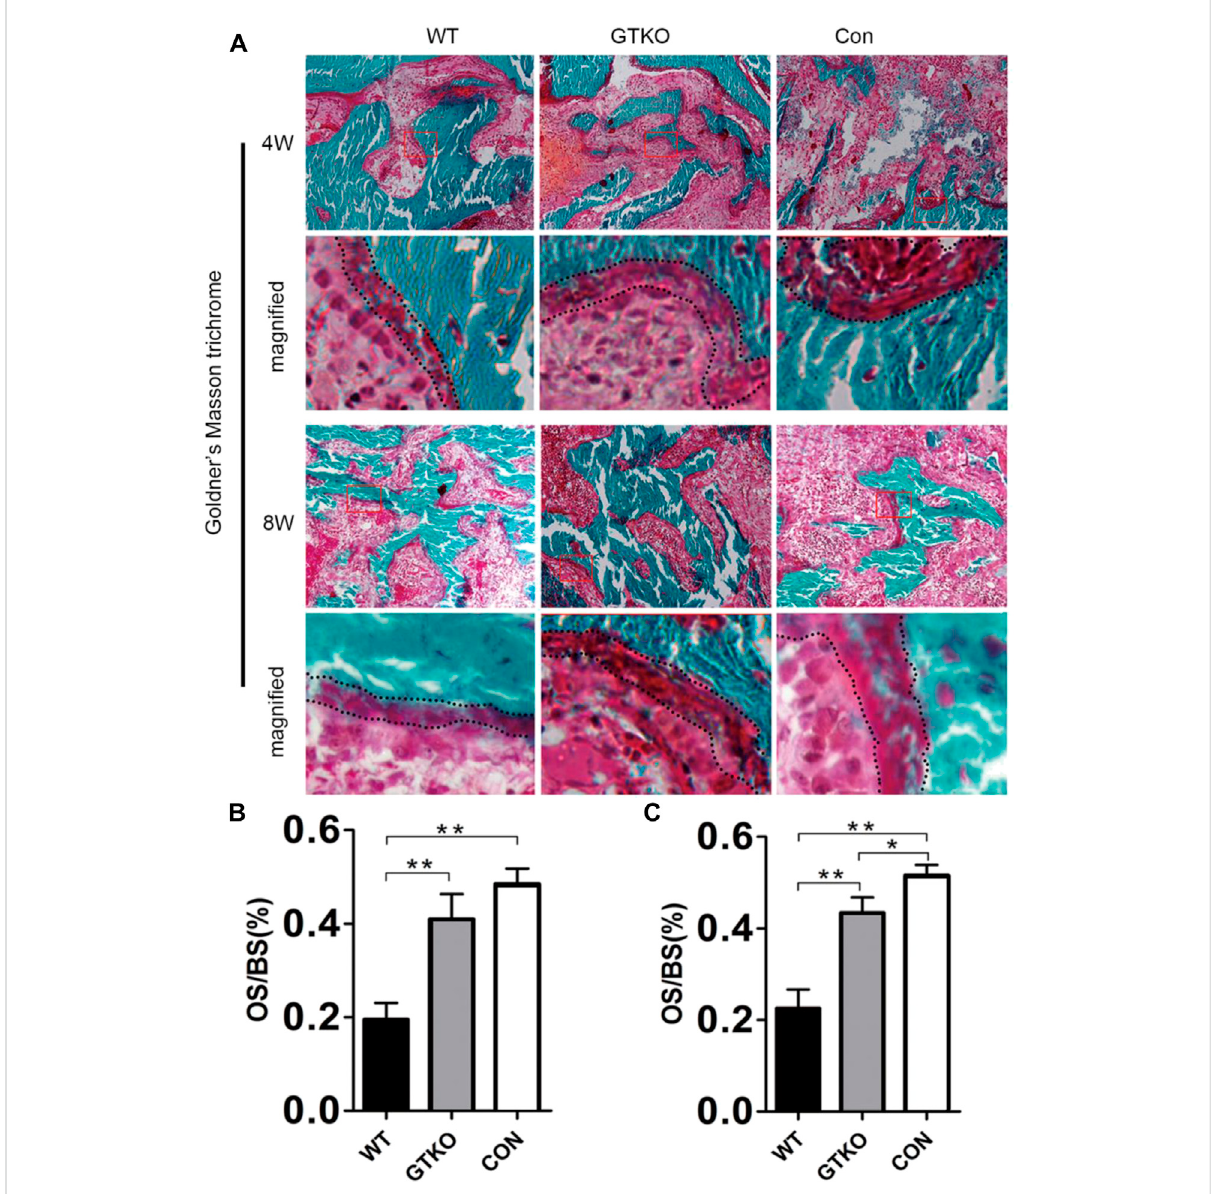
FIGURE 5 Histomorphometricassessmentofnewboneregeneration. (A) :Goldner ’ sMassontrichromestainingofthebonedefectareastransplantedwith thematerialsshown, 4 and 8 weeks after surgery (×200) and (B,C) statistical analysis of theosteoidper bone surface(OS/BS).Boxed areais enlarged in the panel below; the osteoid border is marked by a dotted line. Data are shown as mean ± SD.* p < 0.05, ** p <